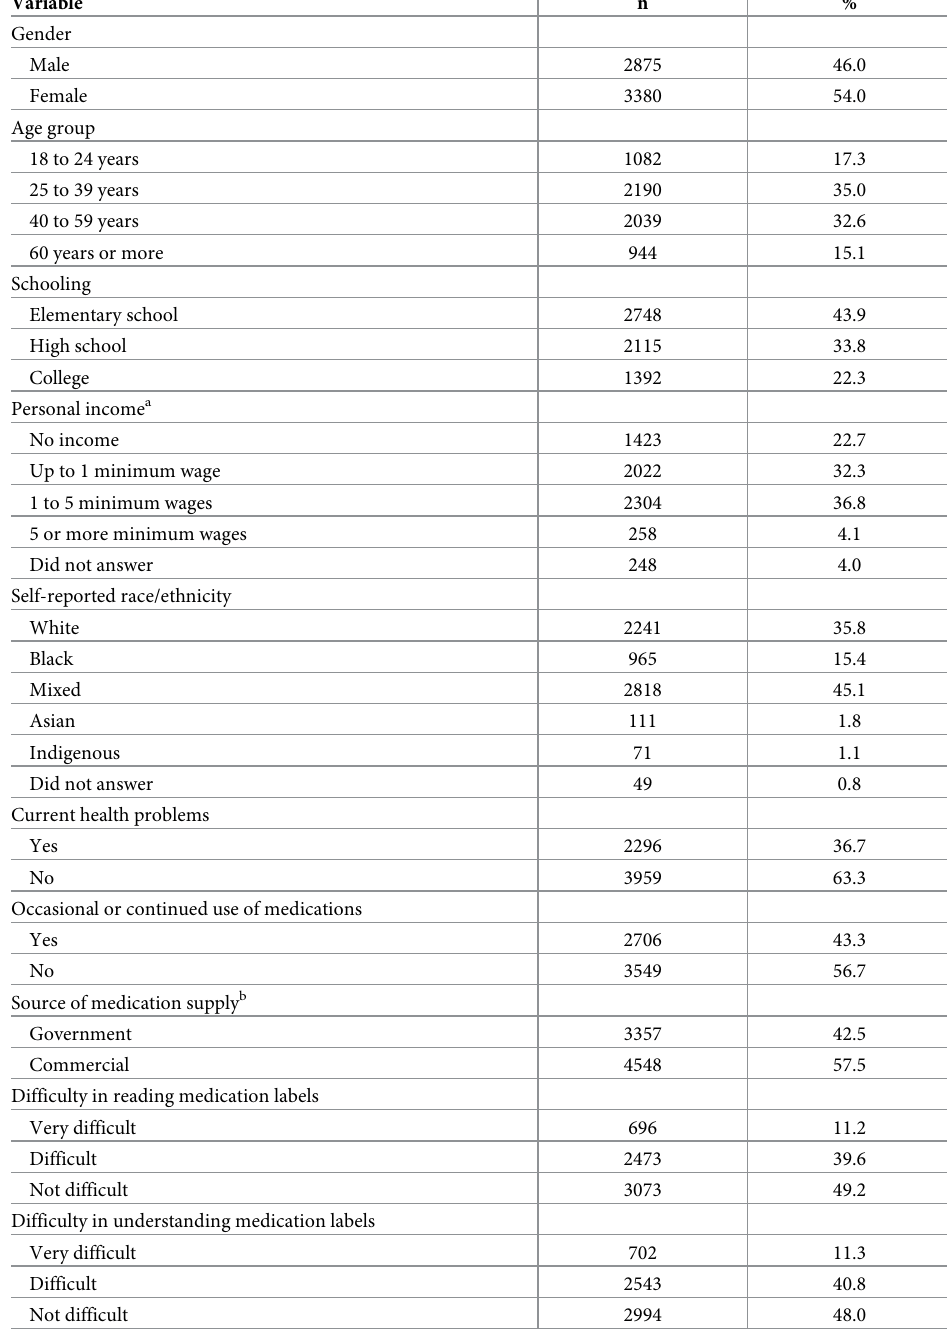
Table 1. Sociodemographic characteristics and information on medication use of the participants in the medica- tion labeling survey. (n =